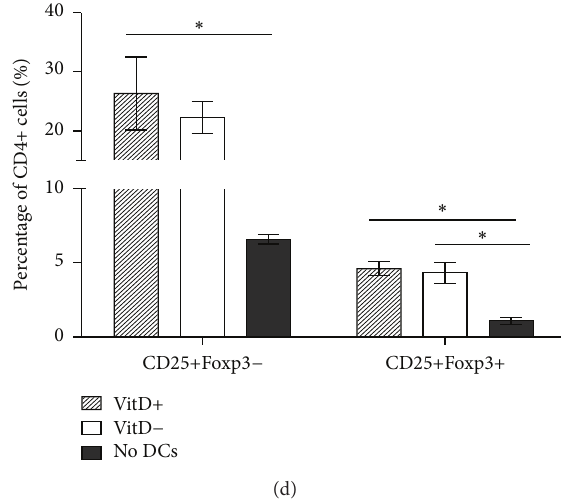
Figure 5: Dietary vitamin D 3 did not modify neuropilin expression on Foxp3+ T cells from the skin, SDLN, lung, or ADLN or alter Reg cells. Female offspring born to vitamin D 3 -replete or vitamin D 3 -deficient the capacity of DCs from the ADLN to induce new Foxp3+ T Reg BALB/c mothers were maintained on the vitamin D 3 -replete (vitD+) or vitamin D 3 -deficient (vitD − ) diets (resp.) until 8 weeks of age. In (a), the expression of neuropilin in the skin, SDLN, lungs, and ADLN is shown, with cells from vitamin D 3 -replete and vitamin D 3 -deficient mice shown in blue and black, respectively (unstained = red shaded). Data are representative of two experiments. In (b), MHC class II hi CD 11 c med cells from the ADLN were sorted with the prepurity (left) and postpurity (right) shown, as determined by flow cytometry. These cells were cocultured with lymph node cells from OVA-TCR transgenic mice (DO11.10 mice) at a ratio of 0: 1 (no DC) or 1: 40 (with DC) for 62 h with OVA peptide. (c) The gating strategy for determining the percentage of CD25+Foxp3 − and CD25+Foxp3+ cells after 62h of coculture. In (d), the percentages of CD25+Foxp3 − and CD25+Foxp3+ cells of CD4+CD3+ cells are shown as mean ± SEM for 3 wells/treatment. ∗ 𝑝 < 0.05